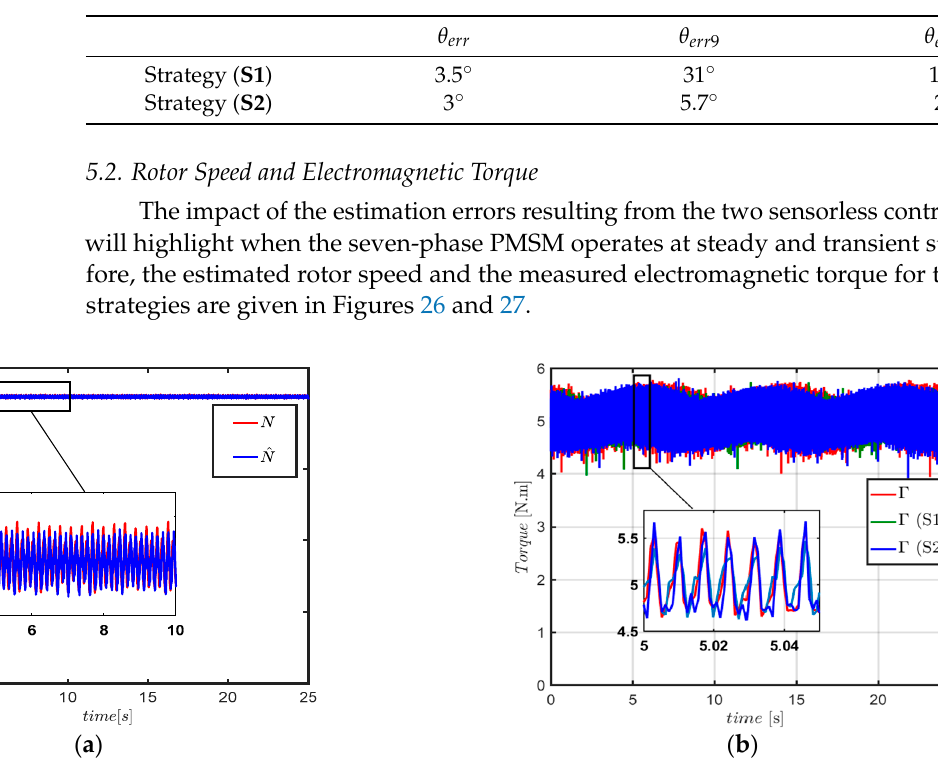
Figure 27. Experimental waveforms for variable rotor speed: ( a ) measured and estimated rotor speed, ( b ) measured torque when the seven-phase PMSM is controlled by the encoder, sensorless control ( S1 ), and sensorless control ( S2 ).